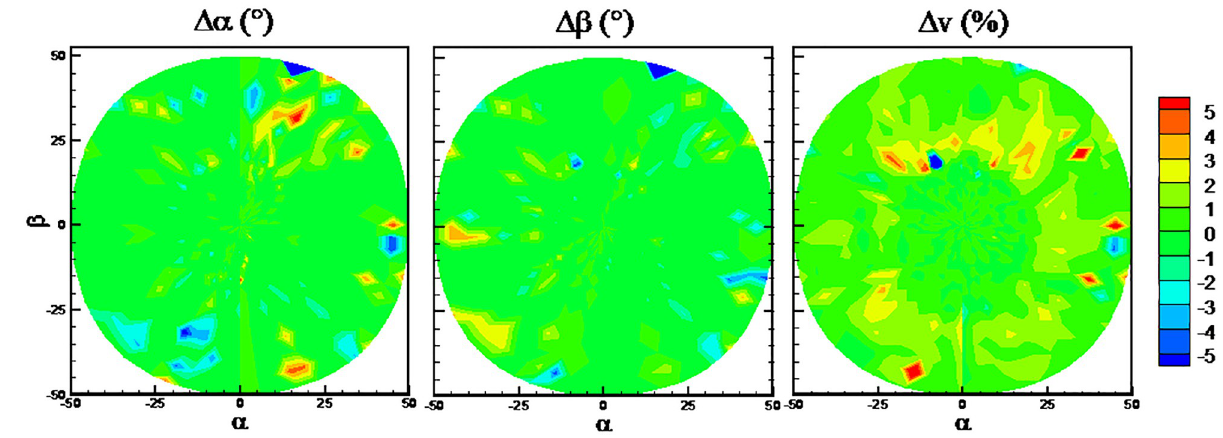
Fig 13. Error distributions with DTs algorithm.